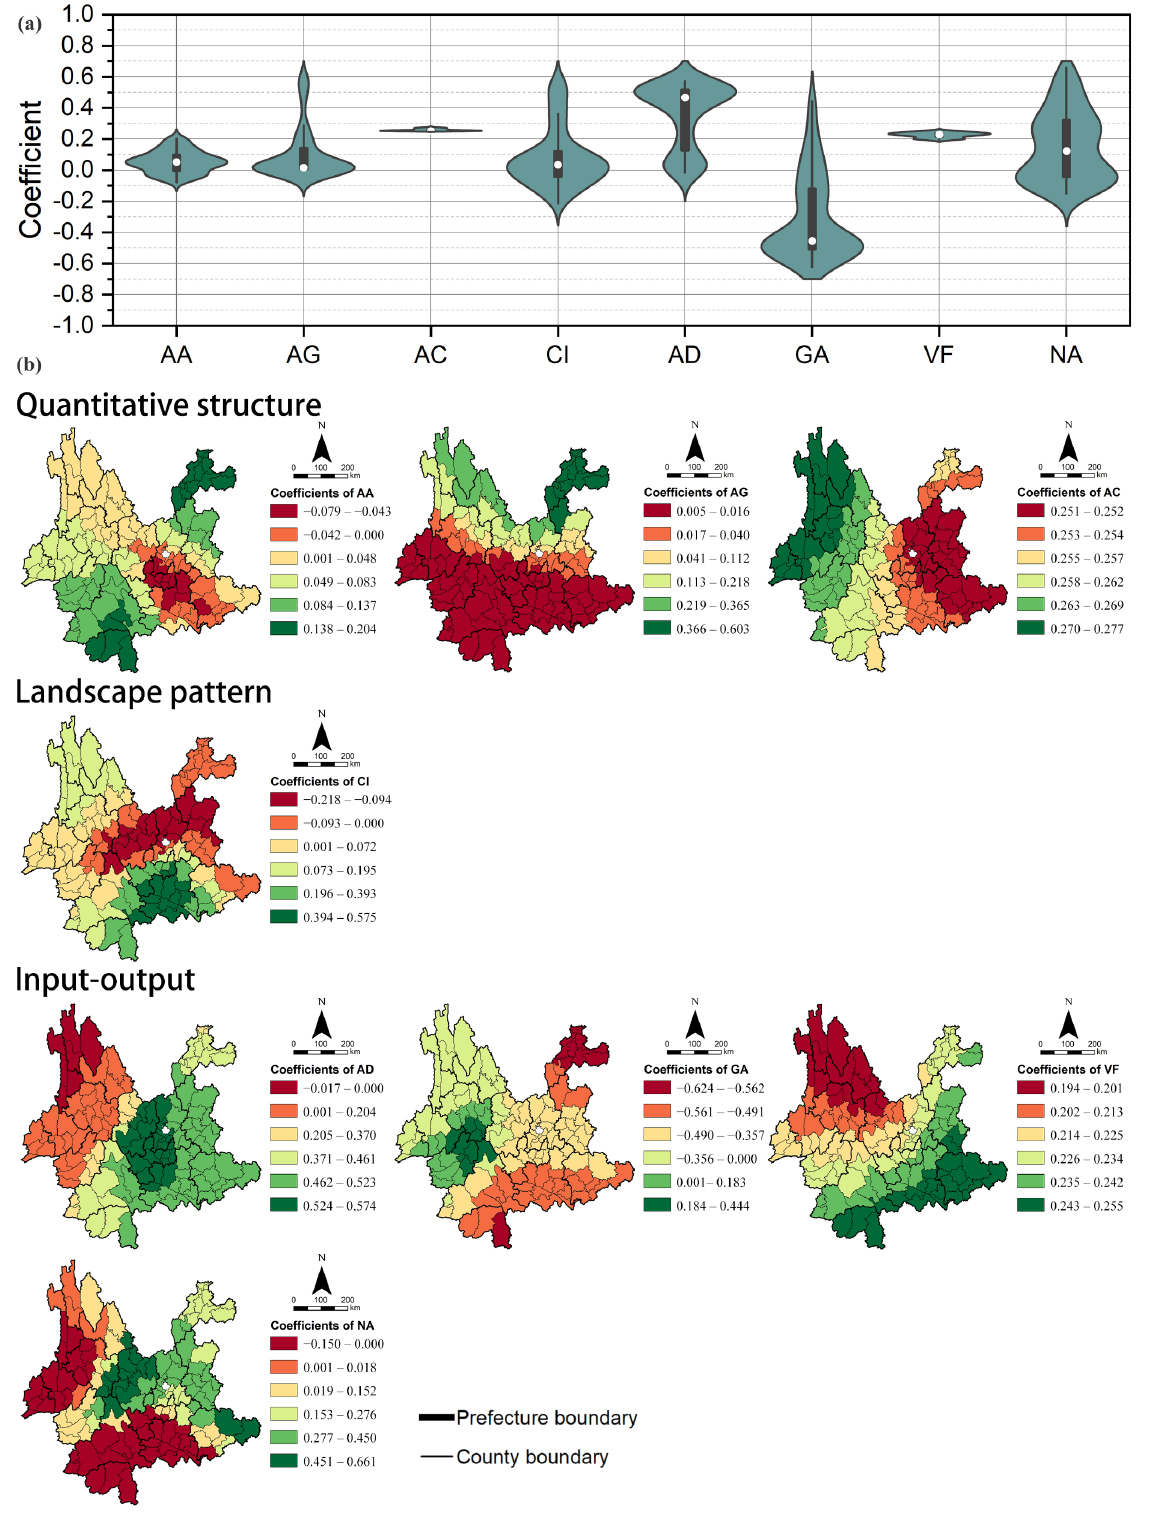
Figure 6. Coefficient distribution of each LUT factor in CPA. ( a ) Violin diagram of coefficient distribution. ( b ) Coefficient of the driving mechanism in space.